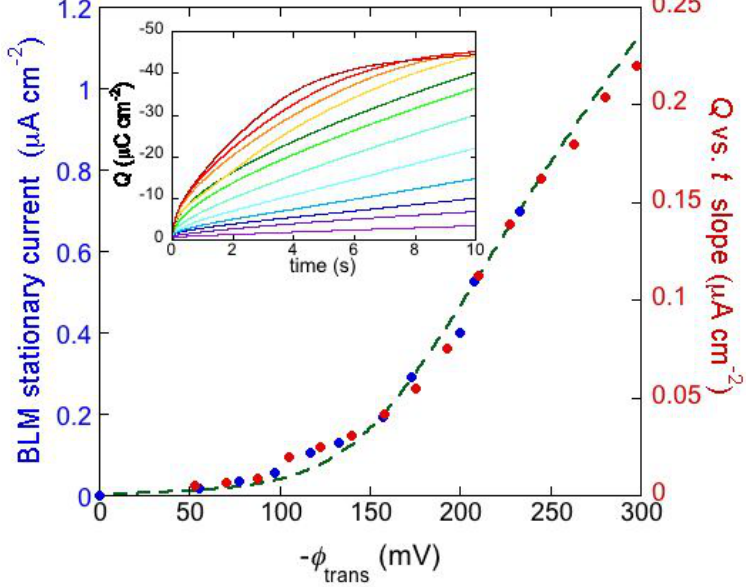
Figure 8. The inset shows a number of charge vs. time curves following potential jumps from − 0.25 V towards progressively more negative final potentials at a DPTL/DPhyPC tBLM incorporating gramicidin from its 1.0 × 10 − 7 M solution in aqueous 0.1 M KCl. The red circles are values of the slope of the linear portion of the charge vs. time curves, plotted . The blue circles are values of the stationary against the transmembrane potential ϕ trans current at a conventional BLM incorporating gramicidin A from its 2 × 10 − 11 M solution in aqueous 1 M NaCl, plotted against ϕ (from Figure 2 in Ref. [34]). The dashed green trans curve was calculated as outlined in the